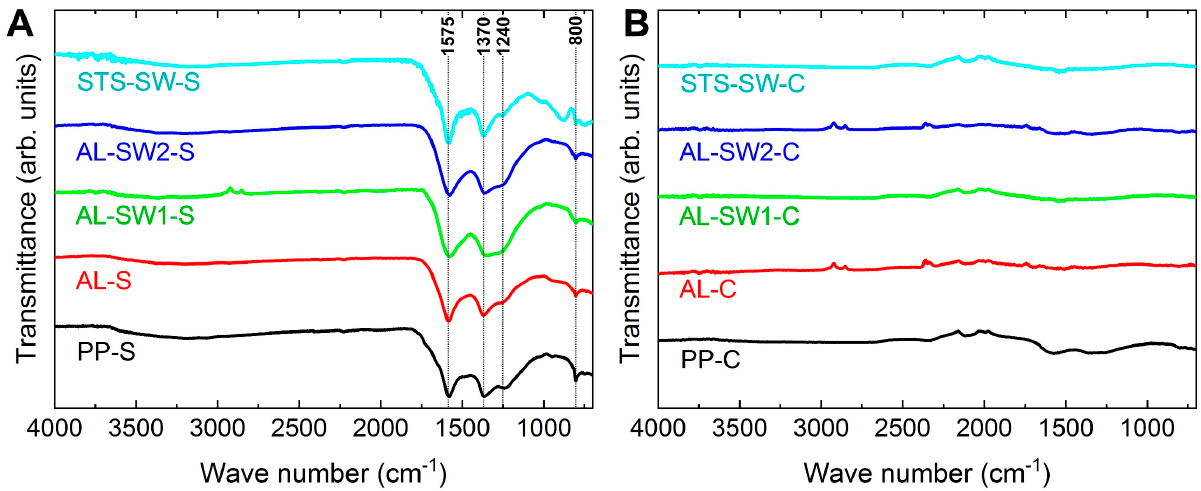
Figure 5. FTIR spectra of ( A ) stabilized and ( B ) carbonized nanofibers. The y-scales are identical in both diagrams, while the lines are vertically shifted for clarity.